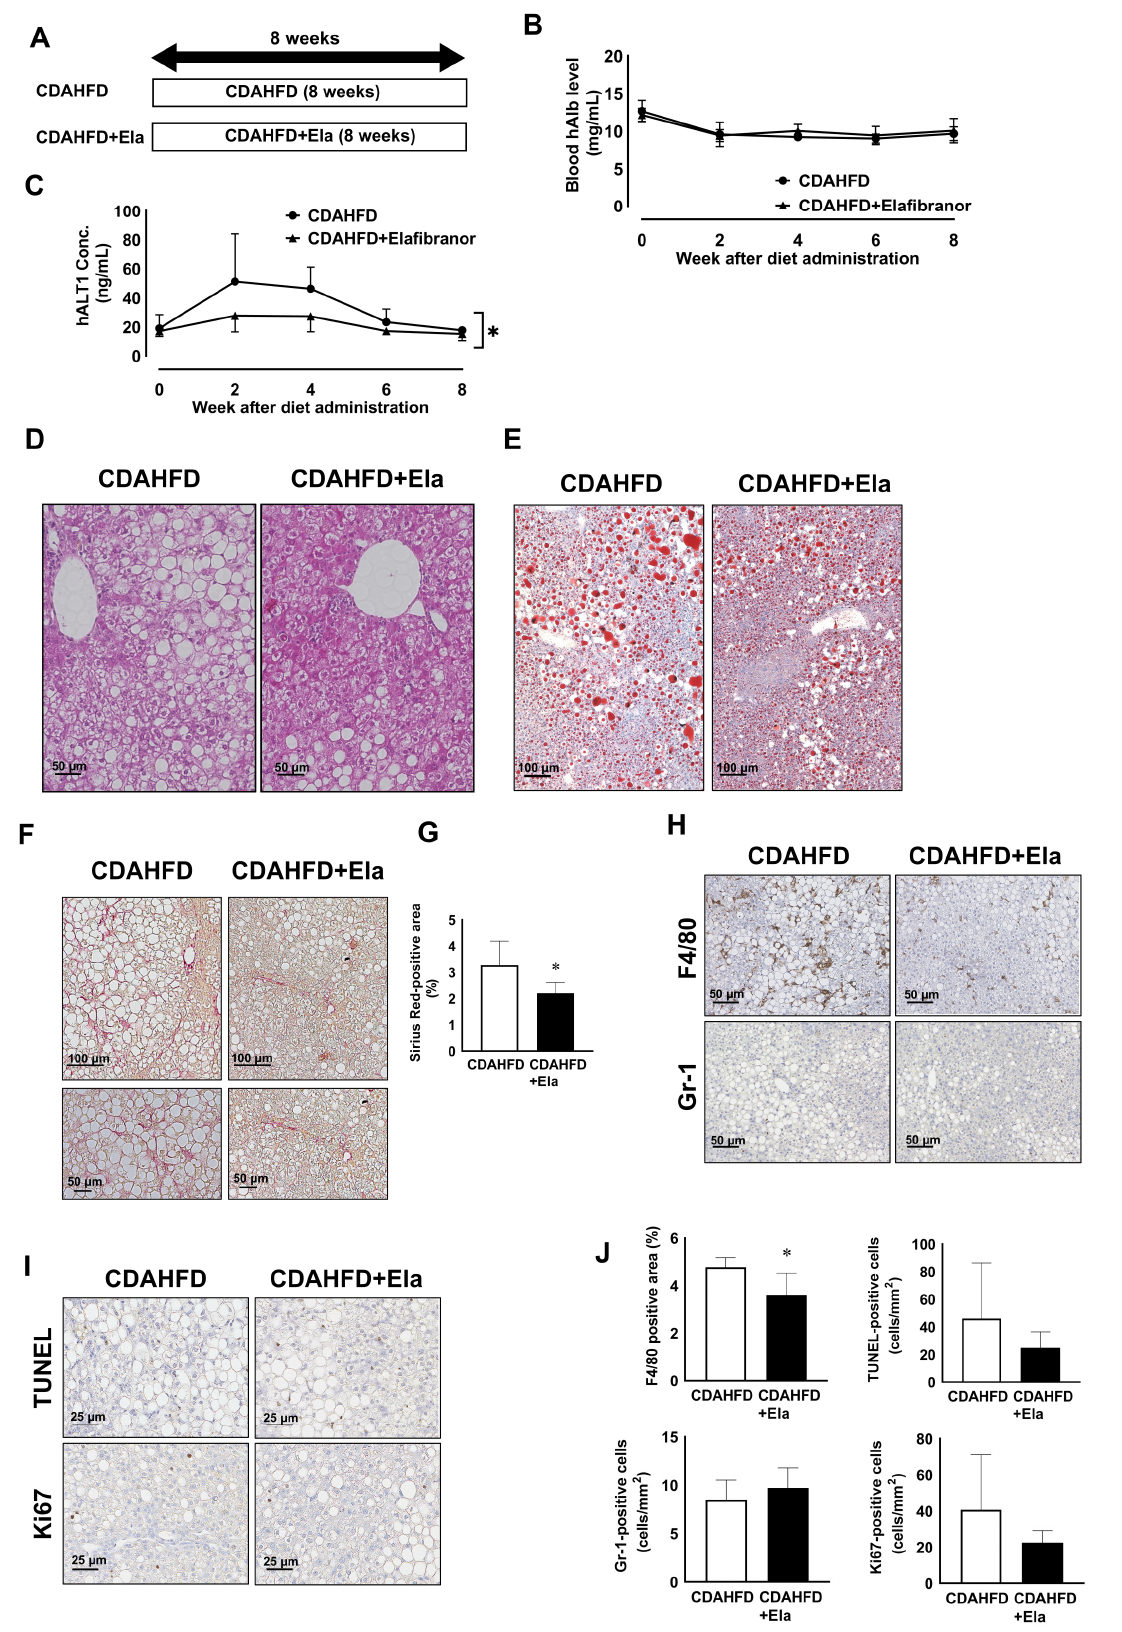
Figure 5. Elafibranor ameliorated steatosis, ballooning and fibrosis. Schematic figure for the prevention study with Elafibranor using CDAHFD-fed chimeric mice ( A ). Time course changes in the blood h-Albumin ( B ) and human specific ALT1 levels ( C ) of the CDAHFD with (closed triangle) or without (closed circle) Elafibranor groups. Representative im-